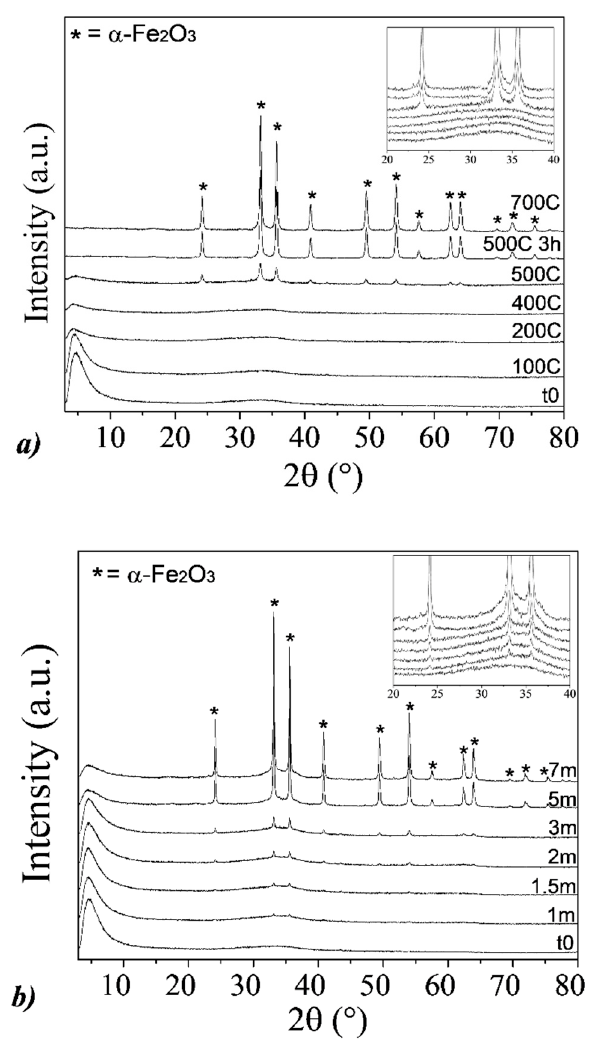
Figure 6. XRD patterns of Fh 1M samples: ( a ) At di ff erent aging times (t 0 = fresh ferrihydrite, m = months) at room temperature; ( b ) at di ff erent calcination temperatures after 2 h (except for the sample calcined at 500 ◦ C, where the result for 3 h is reported too). In the insets: Enlargement of the 20–40 ◦ range.